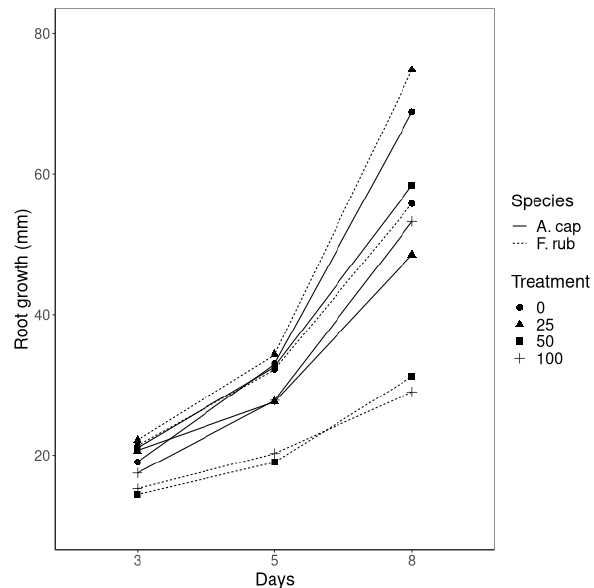
Figure 2. Root growth (mean value, given in mm, of 20 samples per treatment) of A. capilaris and F. rubra during the last eight days after the application of 0, 25, 50 and 100 mg nZVI L − 1 to the hydroponic